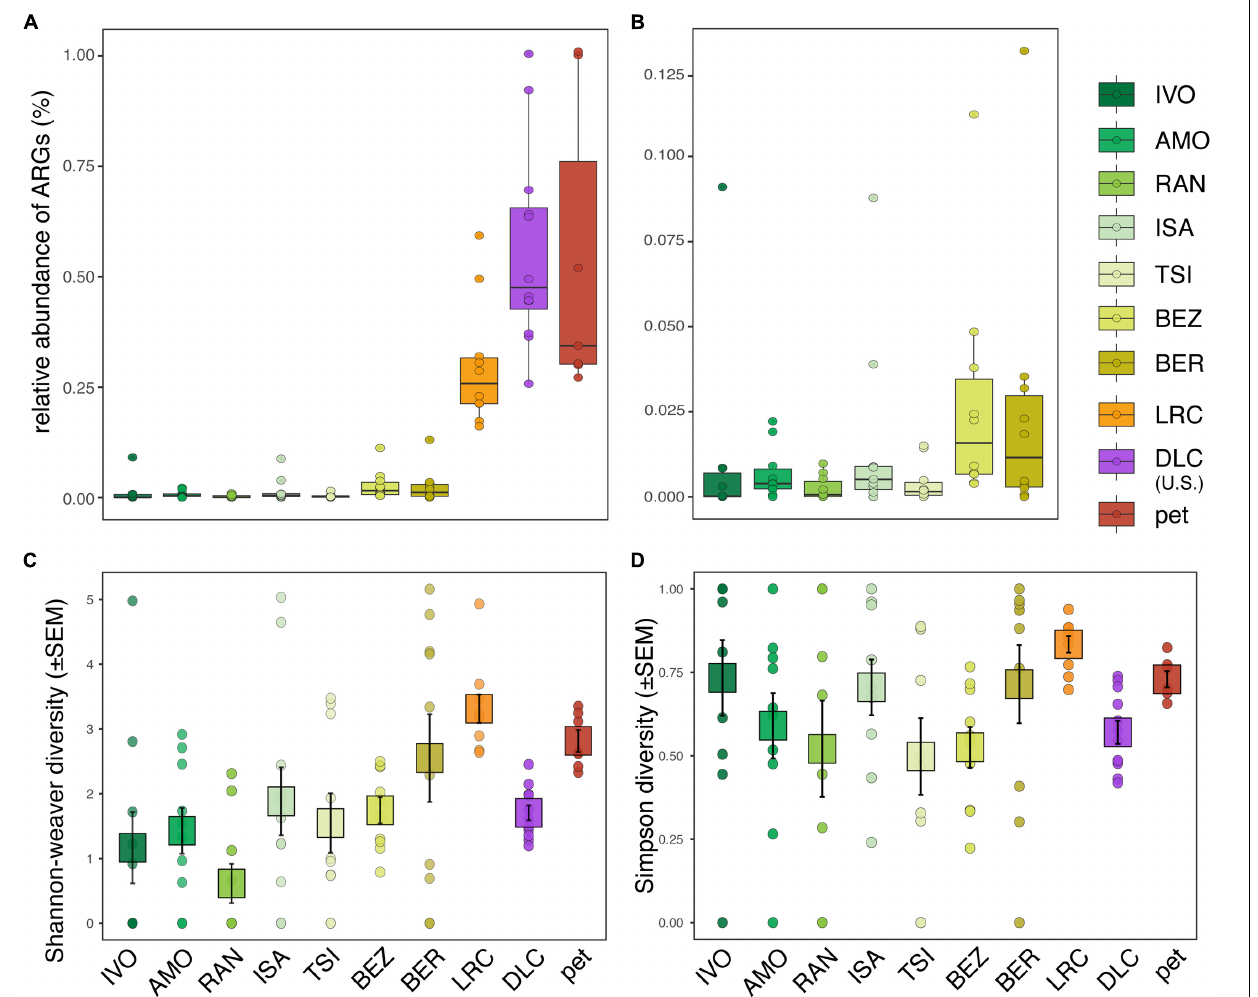
FIGURE 1 | Relative abundance and diversity of antibiotic resistance genes (ARGs) in the gut microbiota of ring-tailed lemurs ( Lemur catta ) living at 10 sites: seven natural habitats, two captive settings in Madagascar, and one captive setting in the United States. Shown are the relative abundances of ARGs in (A) all lemurs and (B) wild lemurs only. Also shown are (C) Shannon–Weaver diversity and (D) Simpson diversity of ARGs across all lemurs. Sites are presented in ascending order according to their ranked level of anthropogenic disturbance ( Table 1